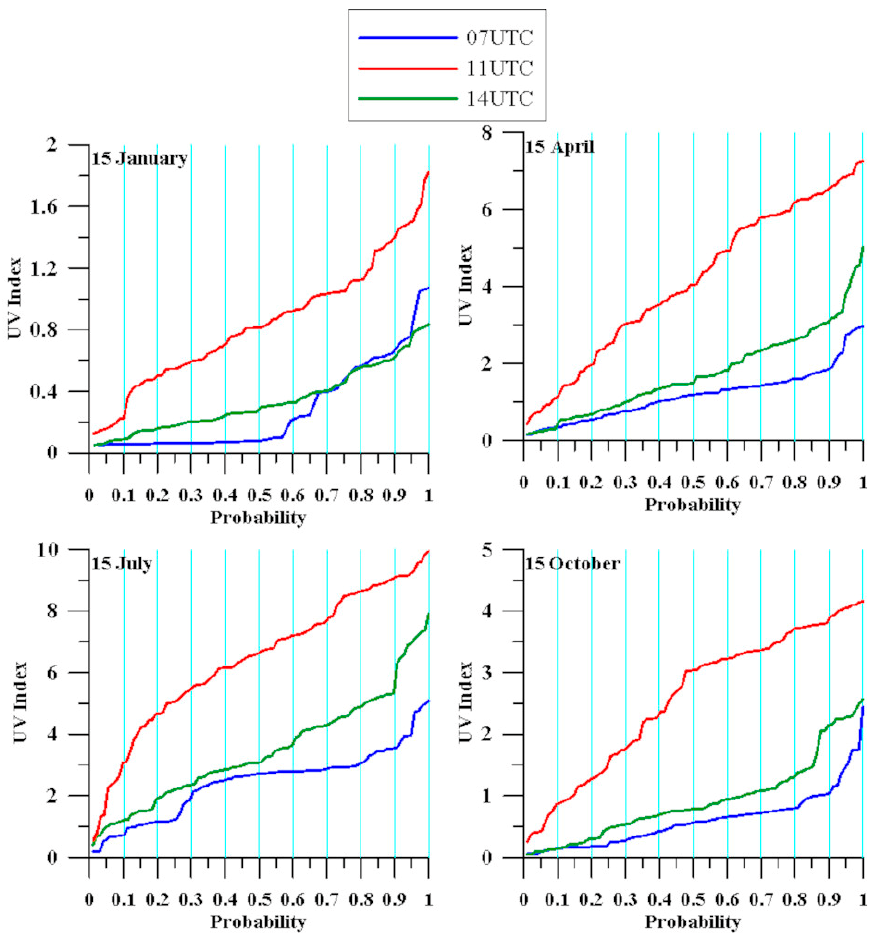
Figure 4. Empirically determined probability distribution function for four days of the year (15 January ( upper left ), 15 April ( upper right ), 15 July ( lower left ), 15 October ( lower right )) and three hours of the day.